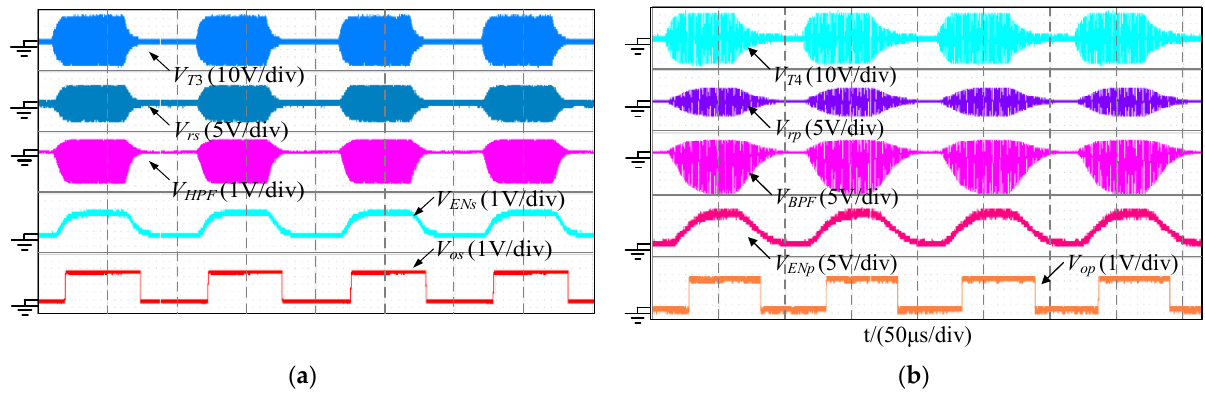
Figure 15. The forward and backward information transfer with no power transfer. ( a ) Only forward information transfer. ( b ) Only backward information transfer.